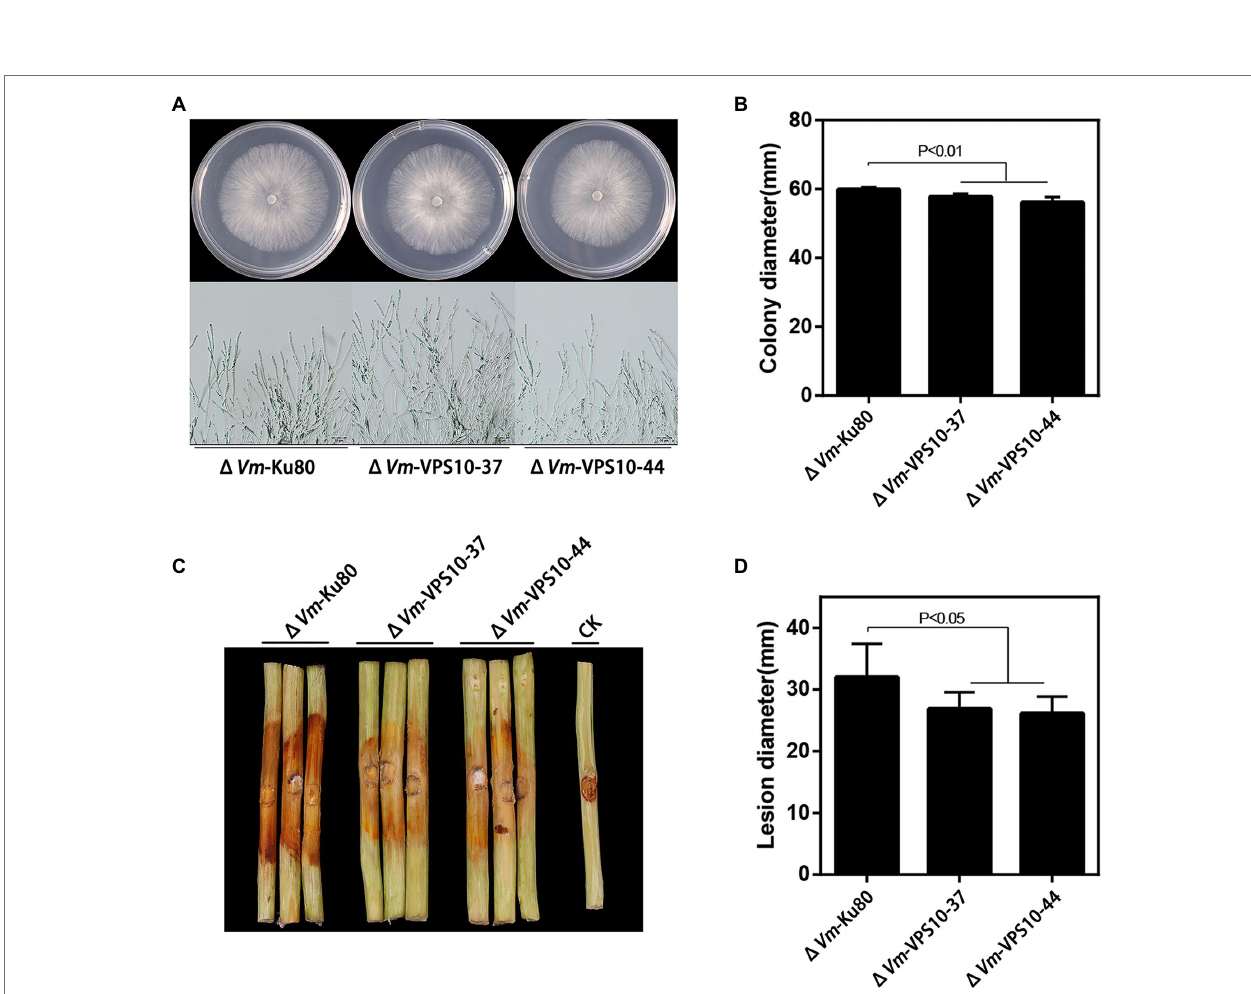
FIGURE 7 | Phenotypical analysis of Vm - VPS10 deleted mutants ( Δ Vm - VPS10 ) and Δ Vm - Ku80 . (A) Colony morphology of Δ Vm - Ku80 and Vm - VPS10 deleted mutants ( Δ Vm - VPS10 -37 and Δ Vm - VPS10 -44) after 48 h incubation in PDA at 25 ° C. (B) Colony diameters of Δ Vm - Ku80 and Δ Vm - VPS10 -37, Δ Vm - VPS10 -44 after 48 h incubation. Data represent mean ± SD. (C) and (D) Pathogenicity test of Δ Vm - Ku80 and Δ Vm - VPS10 -37, Δ Vm - VPS10 -44 after 5 dpi. Three representative diseased twigs are shown. The pathogenicity test was independently repeated three times, each time with six replicates. CK represents a negative control. Data represent mean ±